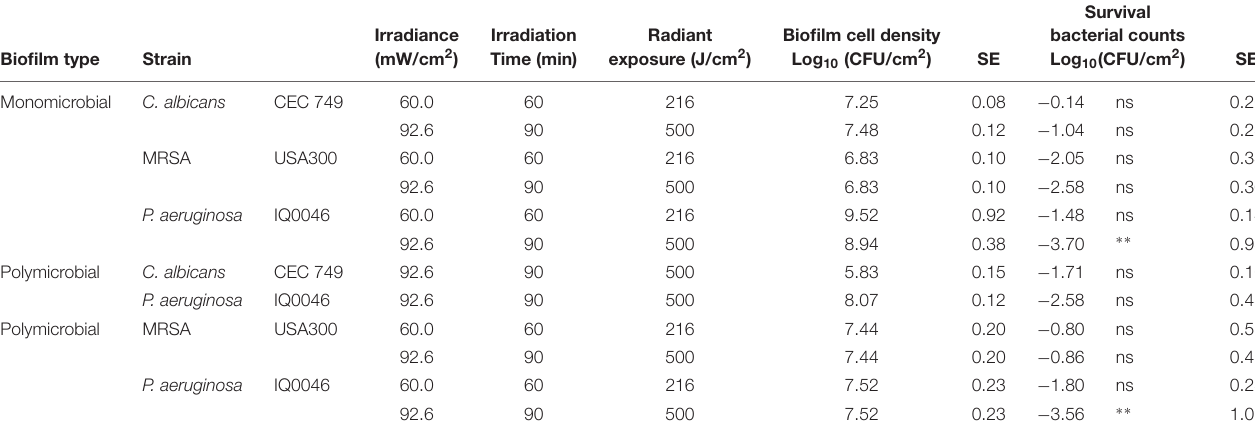
TABLE 3 | Antimicrobial blue light (405 nm) inactivation of biofilms grown in the CDC biofilm reactor after 48 h of